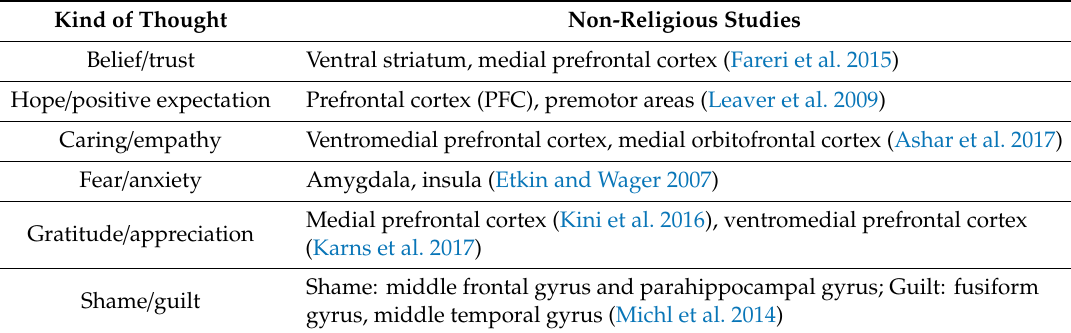
Table 2. Brain Areas Associated with Specific Kinds of Secular